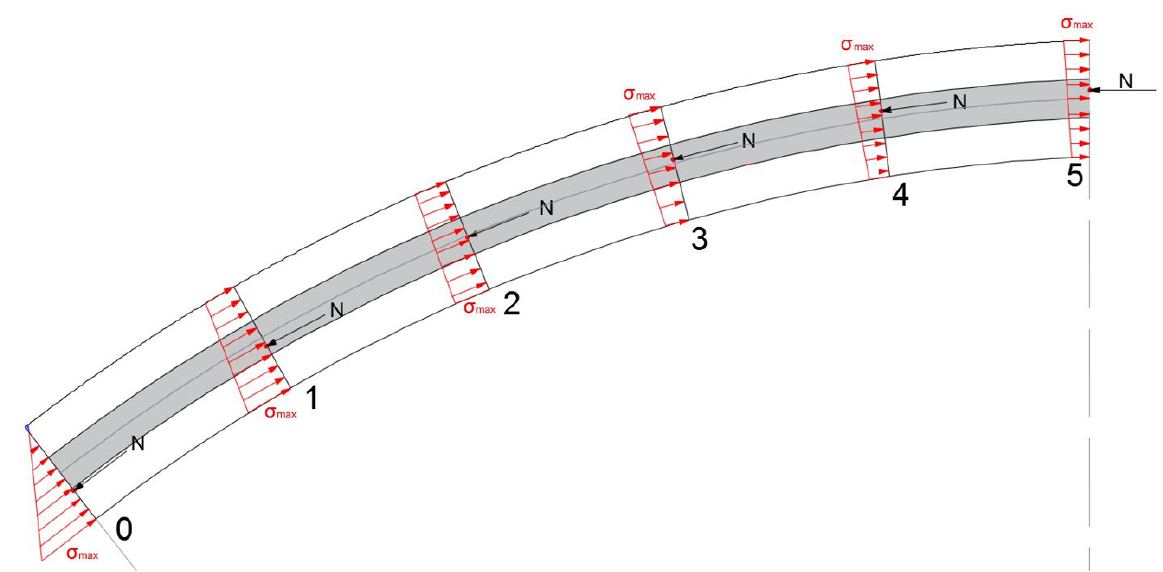
Figure 9: Thrust line of the Porta Napoli arch. Half of the